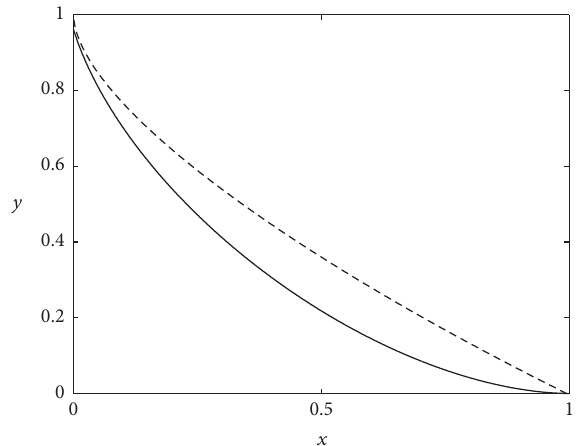
Figure 4: Illustration of the saddle-node bifurcation (part II). The pathway has become monostable. Magnification (not shown) of the top left corner of the phase space reveals that the nullclines do not intersecteachotherinthisarea.Thisisbecausetheasymmetryofthe pathway model has increased as compared to Figure 3. Parameters: = 2.8 , and 𝑟 = 1.2 𝐾 = 0.01 , 𝑟 1 2